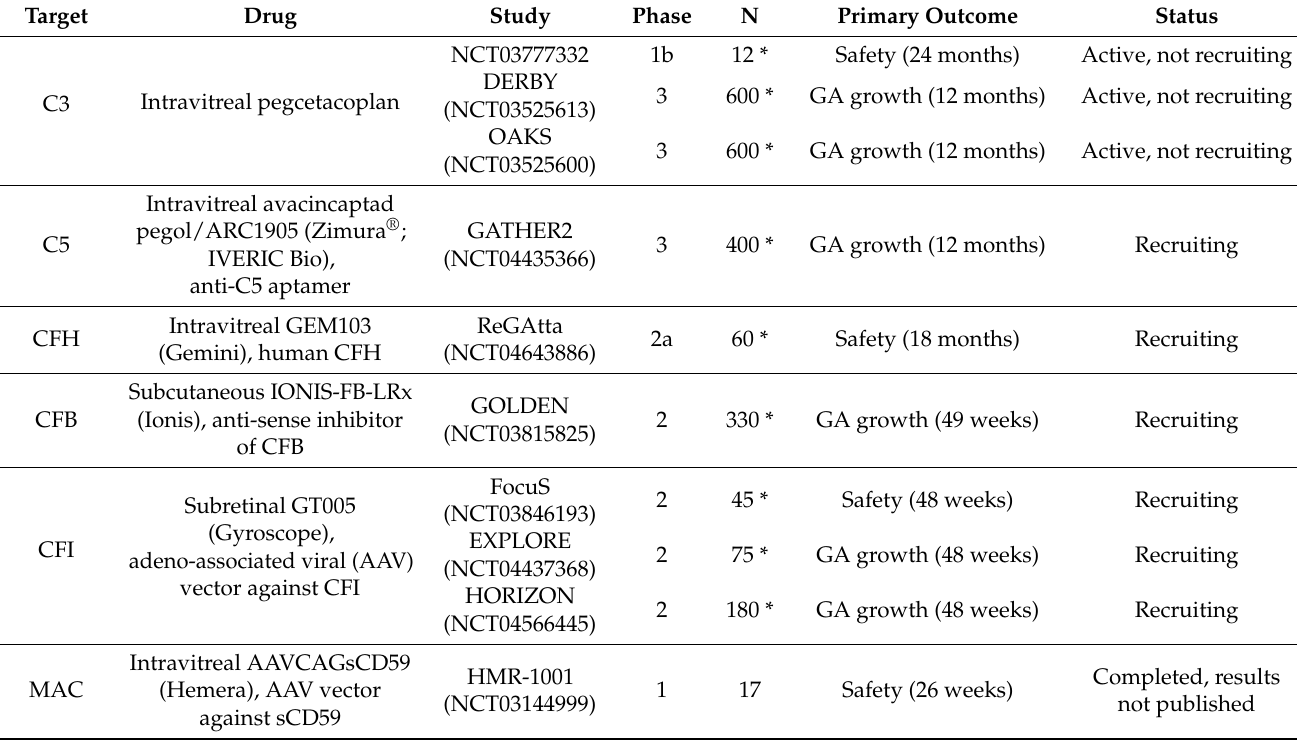
Table 2. Ongoing studies designed to evaluate complement modulation as a novel therapeutic strategy for geographic atrophy (GA); information is current as of March 2021 based on reviewing clinicaltrials.gov. * denotes anticipated